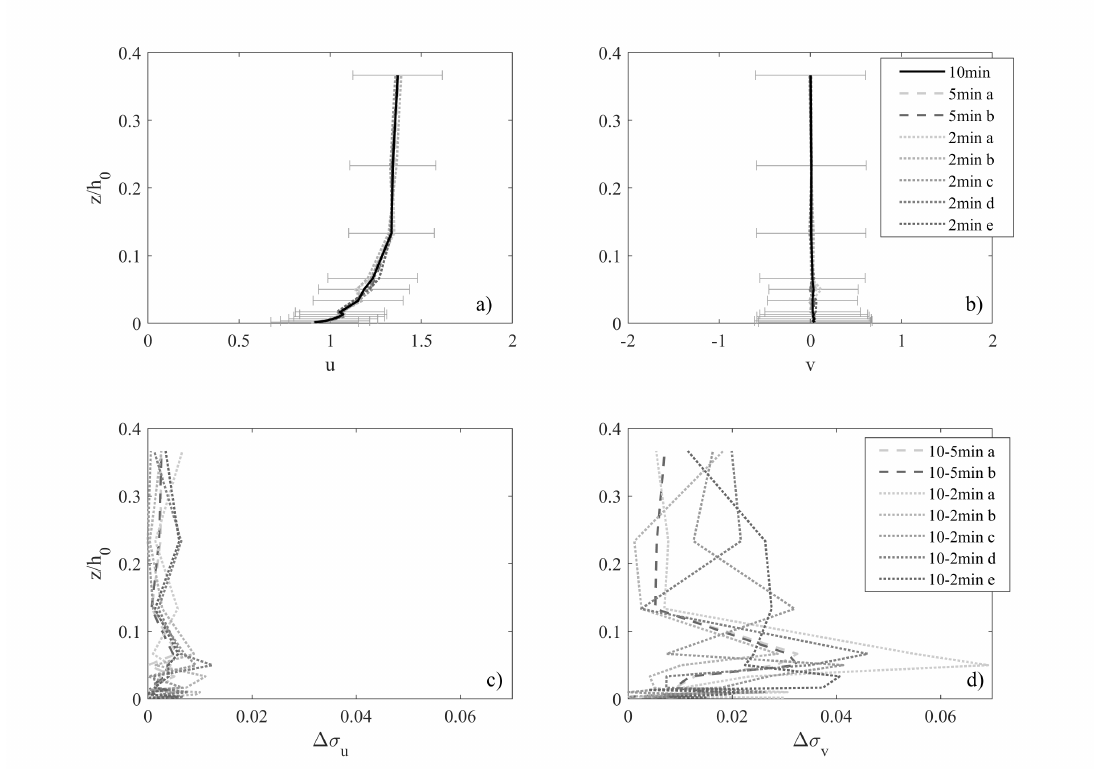
Figure 4. Mean velocity time variability for test 9 (WC, CC, U = 0.14 m/s): dimensionless time-averaged velocity profiles with the different timespans for streamwise ( a ) and crosswise ( b ) velocities, standard deviation different from the 10 min timespan expressed as a fraction of U for streamwise ( c ) and crosswise ( d )